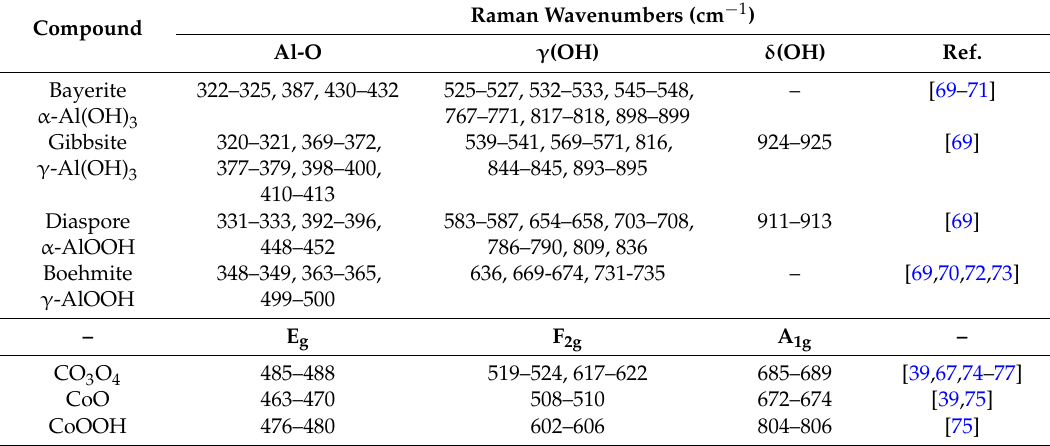
Table 6. Raman band wavenumbers and oxide/hydroxide/oxyhydroxide assignments for the surface films of the Al-Co alloys after cyclic polarization, in 3.5 wt.% NaCl, at 25 ˝